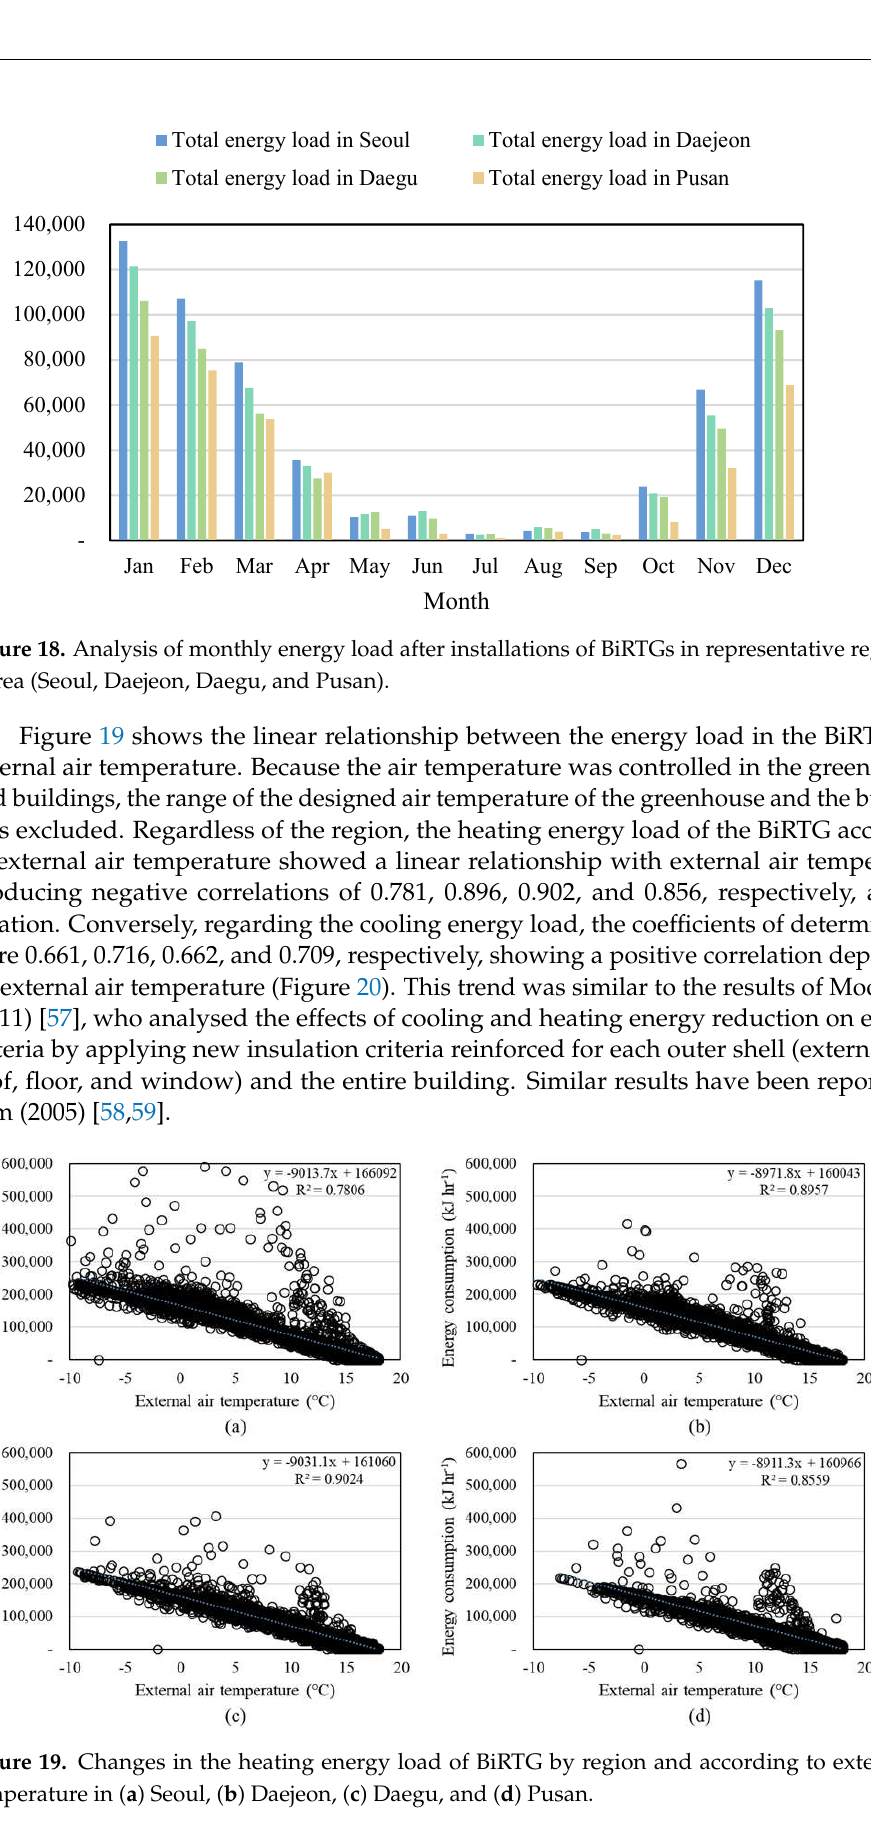
23 of 28 Figure 17. Comparison of monthly energy load of the BiRTG under ATM. 3.6. Thermal Energy Load Analysis of BIRTGs for Representative Areas in Korea Considering the same insulation performance conditions, the estimated heating and cooling energy requirements for the local application of the BiRTG were calculated (Figure